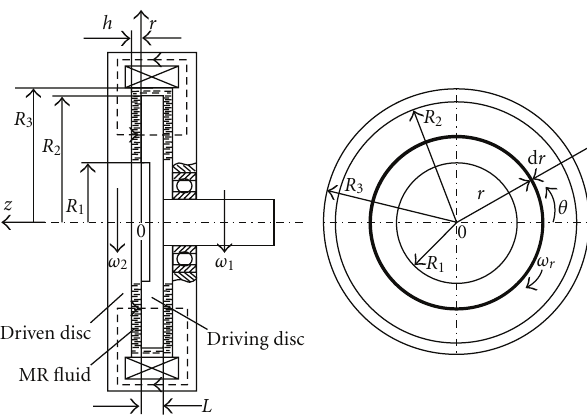
Figure 3: Circular flow mode of MR fluid between the two paral- leled